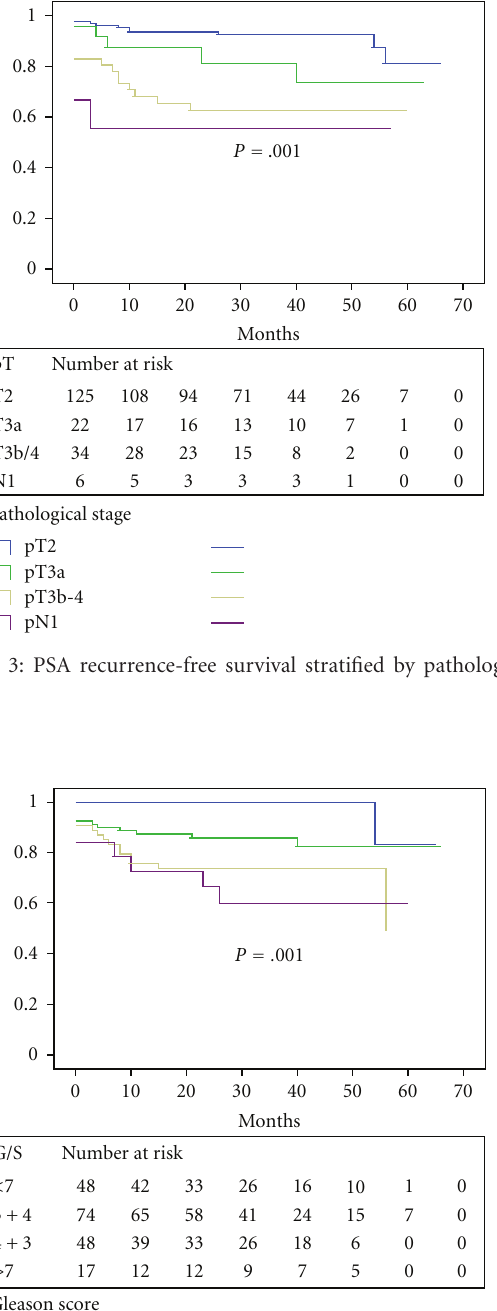
stages, 5-year progression-free survival rate was 93.4% for pT2 tumors, 70.2% for pT3 tumors, and 42.7% for pT4 tumors. Preoperative PSA, Gleason score, tumor stage, nodal status, and surgical margins were significant independent predictors of biochemical recurrence-free survival [19].